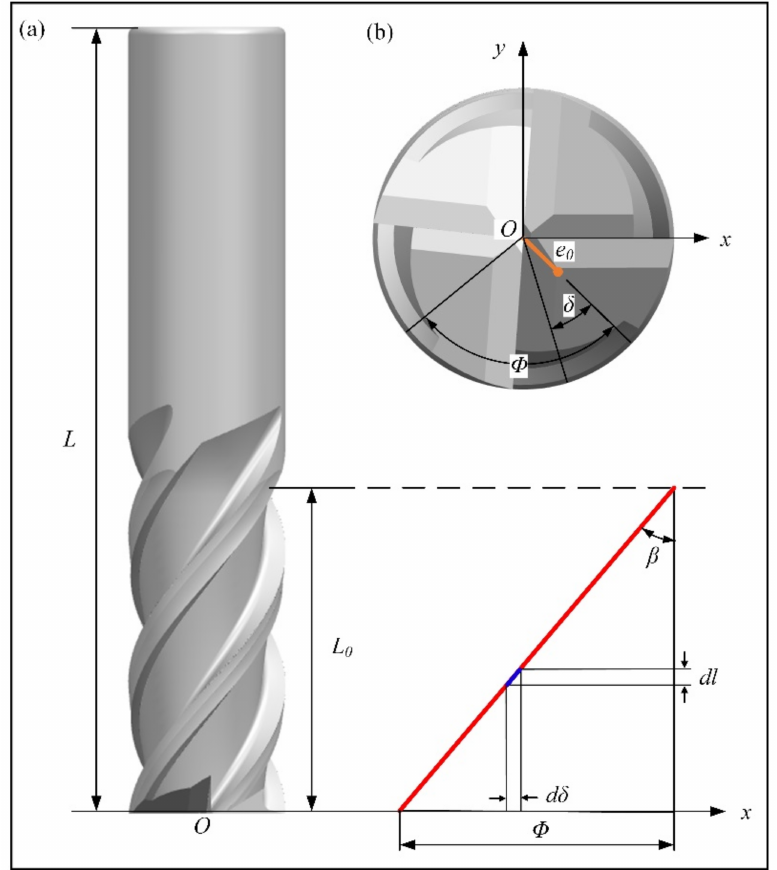
Figure 4. Relationship diagram of eccentricity for unequal-pitch end mill: ( a ) axial; ( b ) radial.